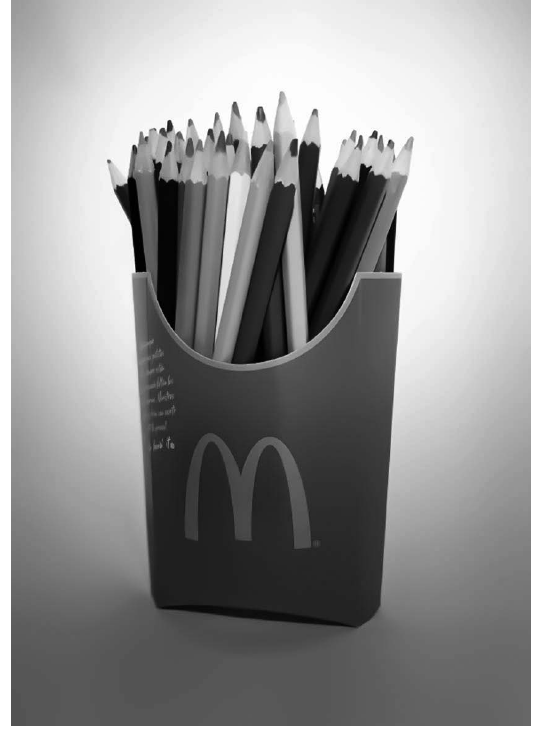
Figure 9. Rocío Rodríguez (2017), Sin título [Untitled]. Photograph produced by a student that reflects the lack of future work prospects for trainee teachers.© R. Rodríguez. Primary Education student. Bachelor’s degree student in Primary